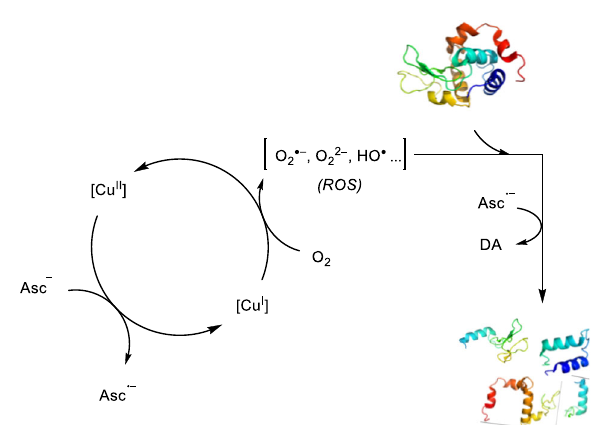
Fig.2|EffectofCu II WD/AscconcentrationonHEWLcleavage. AmountofHEWL (%) cleaved in presence of: A Asc (1mM) and different concentrations of Cu II WD (0.005 – 1.00mM); B Cu II WD (0.05mM) and different concentrations of Asc